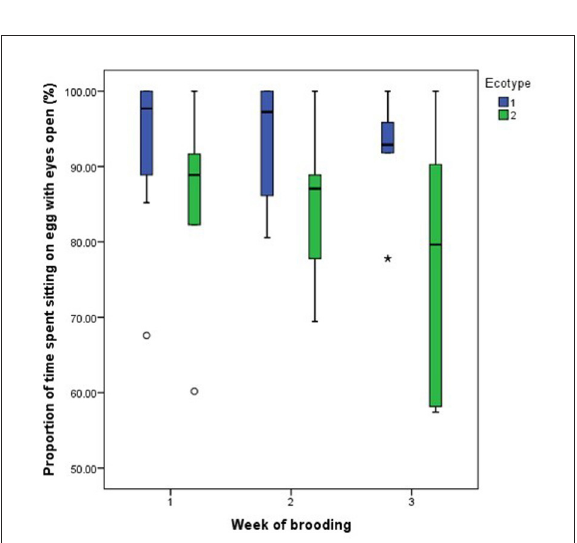
out of 30 (16.7%) FLE hens became broody. A previous study